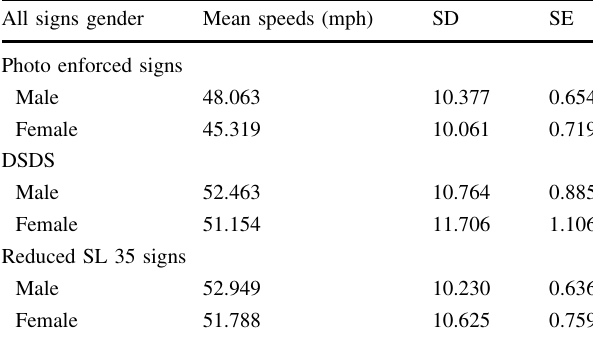
Table 7 Mean speeds by gender—all signs